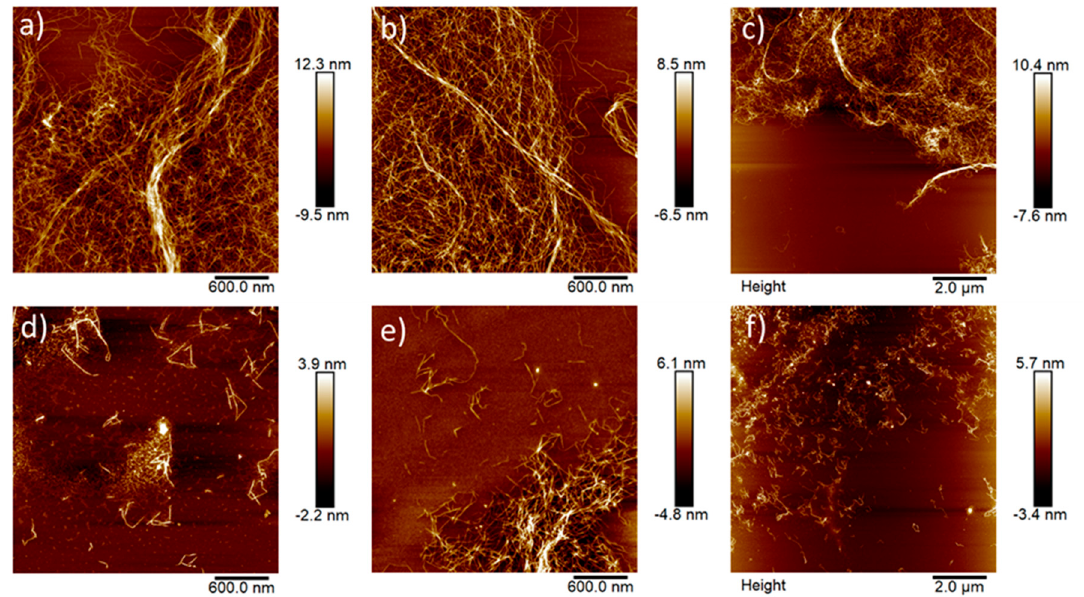
Figure 2. AFM of unbleached (( a – c ) less fibrillated) and bleached (( d – f ) more fibrillated) CNFs.